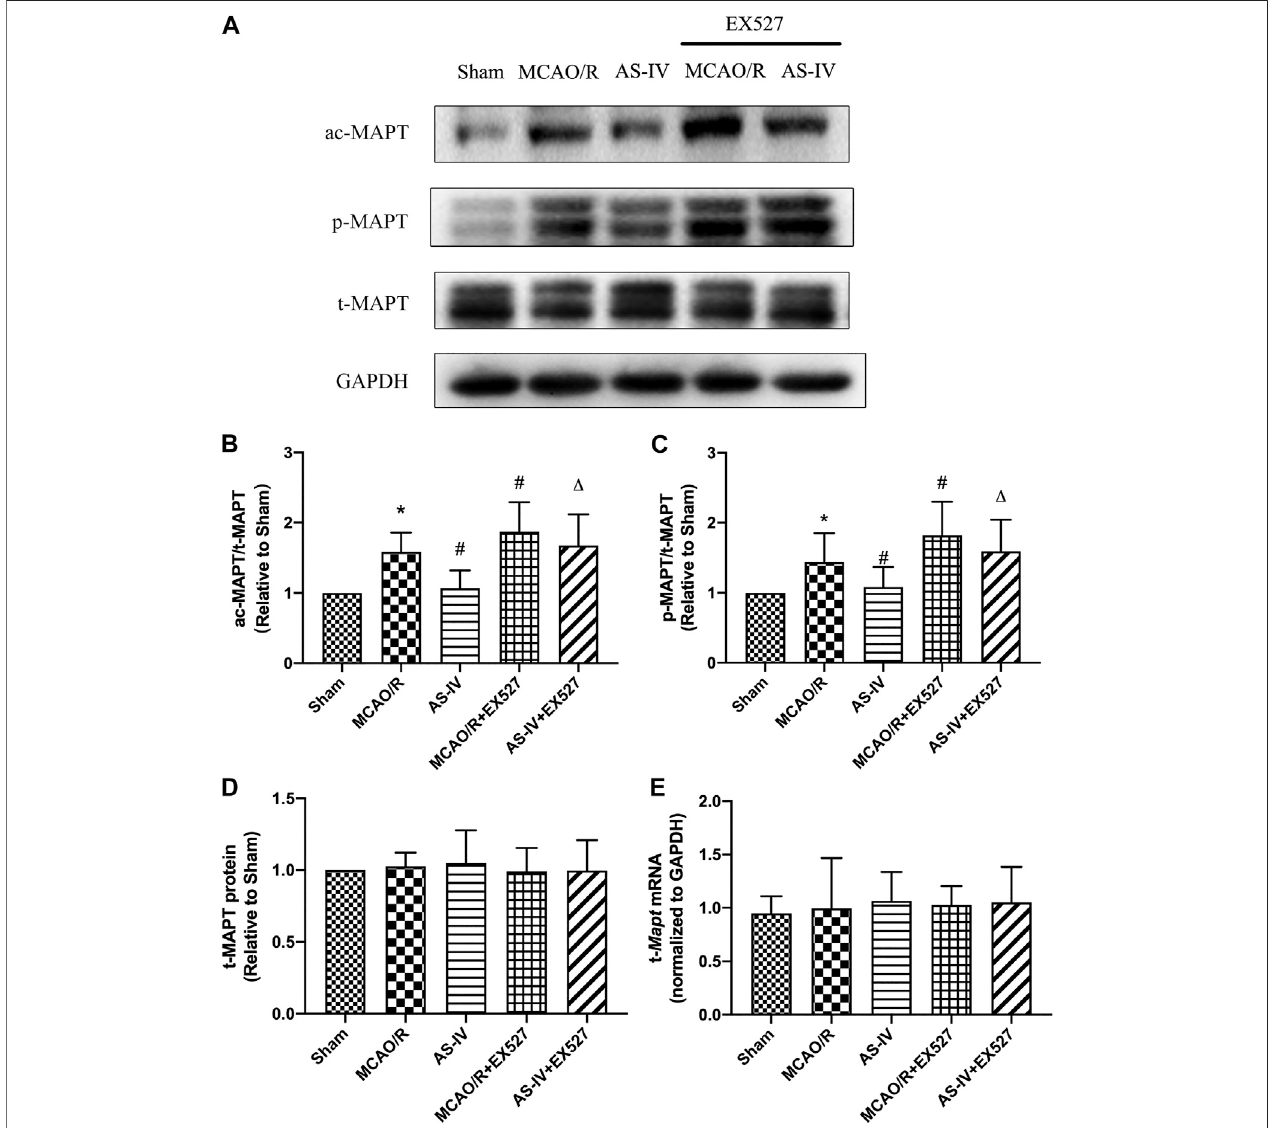
FIGURE9| Theexpressionsoft-MAPT,ac-MAPT, and p -MAPTinSham,MCAO/R,AS-IV,MCAO/R+EX527,andAS-IV+EX527groupat7days afterCIRinjury (mean ± SD, n (cid:1) 6). (A) The results from the Western Blot. (B) Quantitative analysis for the protein level of ac-MAPT. (C) Quantitative analysis for the protein level of p-MAPT. (D) Quantitative analysis for the protein level of t-MAPT. (E) Quantitative analysis for the mRNA level of t-Mapt. * p < 0.05, compared with the Sham group; # p < 0.05, compared with the MCAO/R group; Δ p < 0.05 compared with the AS-IV group.